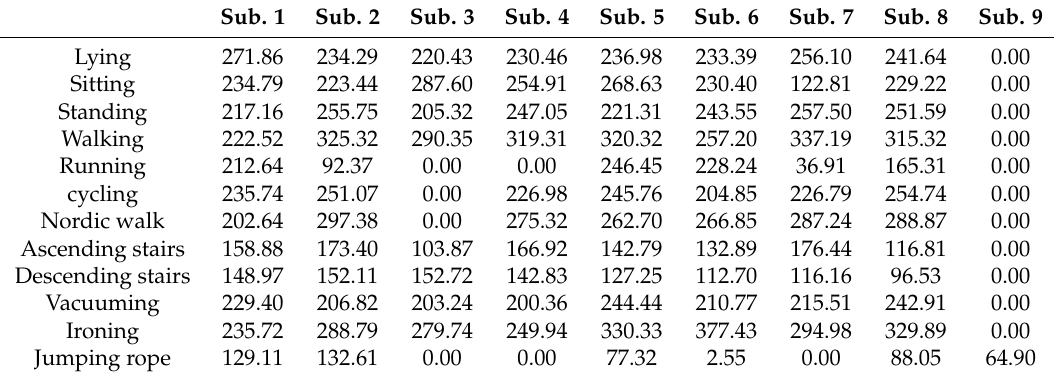
Table 3. Actual time (in seconds) spent by the subjects in each activity (this may differ from the protocol). Sub.,